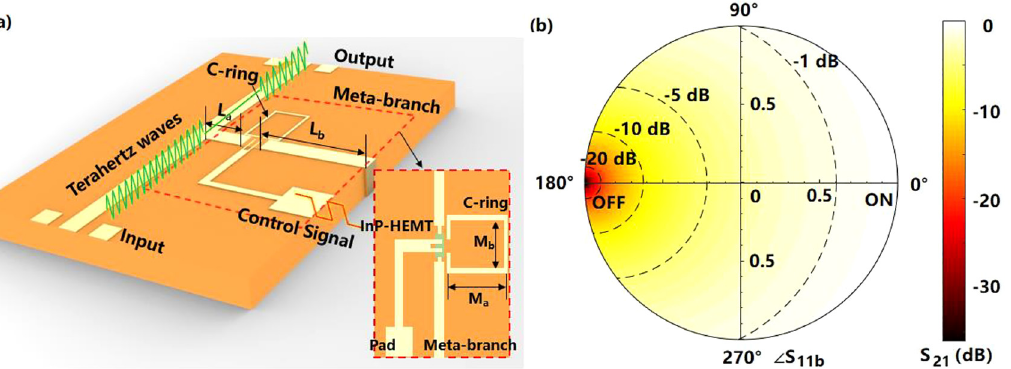
Figure 1: The shematic of the meta-chip and the optimal “ ON/OFF ” points. (a)Theschematicofthemeta-chip,andthemeta-branchconsistsofmicrostrips,InP-HEMTandaC-ring;(b)Therelationbetweenthe S 21 ofthe meta-chip and the S 11 b of the meta-branch/normal branch, in which all possible S 11 b is described by the points in the unit cycle by polar coordinate, and the S 21 is expressed by the gradually changed background